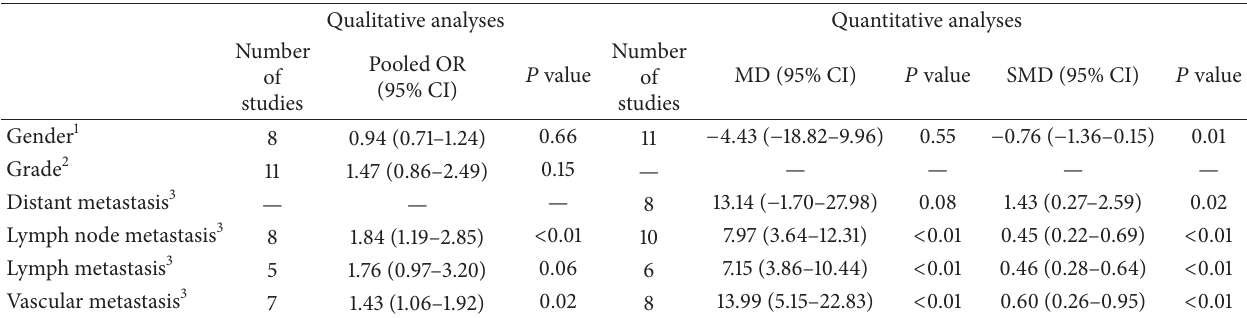
Table 3: Pooled ORs for the association between MVD expression and clinical and pathology features both in qualitative and quantitative